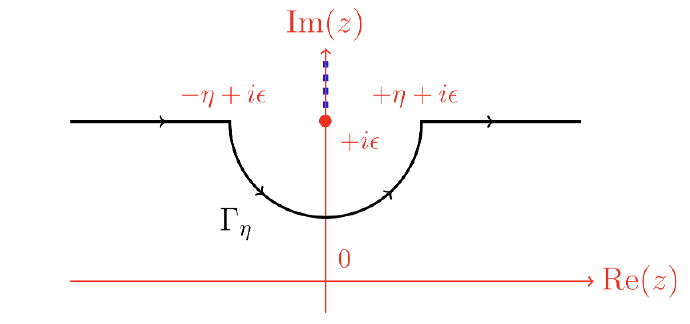
Figure 1 . The contour integral along ( (cid:0)1 + i(cid:15); (cid:17) + i(cid:15) ] [ (cid:0) (cid:17) [ [+ (cid:17) + i(cid:15); + 1 + i(cid:15) ) is equivalent to (B.1) by the Cauchy theorem. Note the branch point at z = + i(cid:15) and the branch cut running upwards from there (stemming from the fact that K 1 ( x ) has a branch point at x = 0 and a branch cut for all Re( x ) <